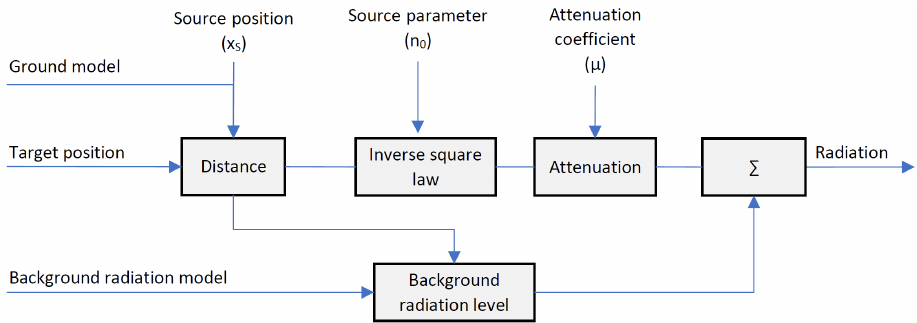
Figure 4. Radiation model: calculation of the expected radiation at any